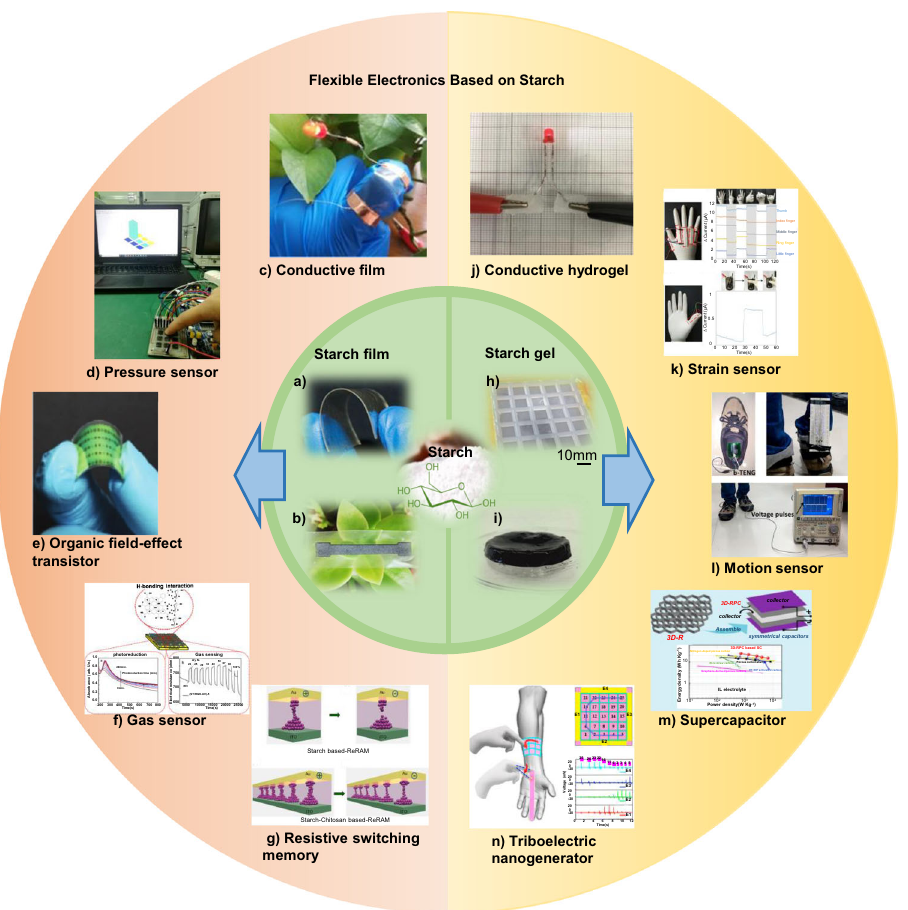
Fig. 1 Summary of starch-based FEs. Left, device on starch fi lms: Starch fi lm ( a ). Reproduced with permission 86 . Copyright 2019, Springer. Starch fi lm ( b ). Reproduced with permission 37 . Copyright 2019, American Chemical Society. c Conductive fi lm. Reproduced with permission 38